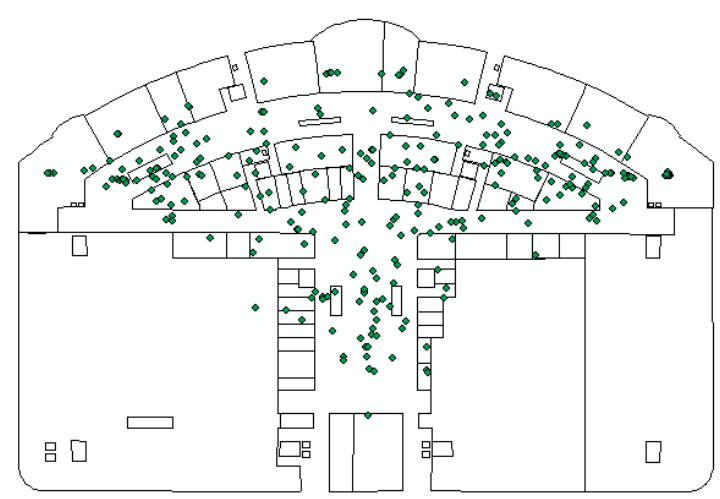
Figure 10. Distribution of drift points (DP).